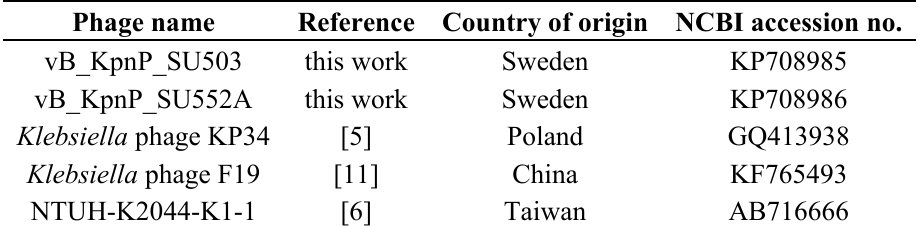
Table 1. Bacteriophages used in this